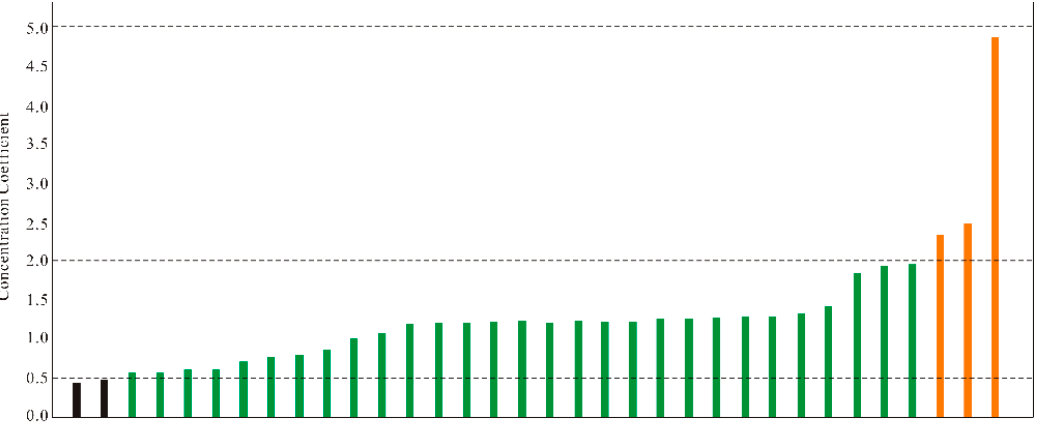
Figure 10. Concentration coefficients (CCs) of trace elements in the Wufeng–Longmaxi shale on the Yangtze Platform, South China.